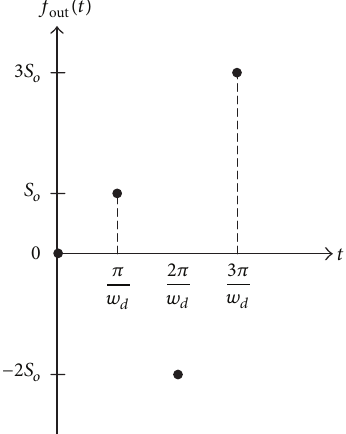
Figure16:Linearincreaseoftheenvelope(idealintheinthelossless situation) for the square wave input. Compare to Figures 1, 3, and 12.